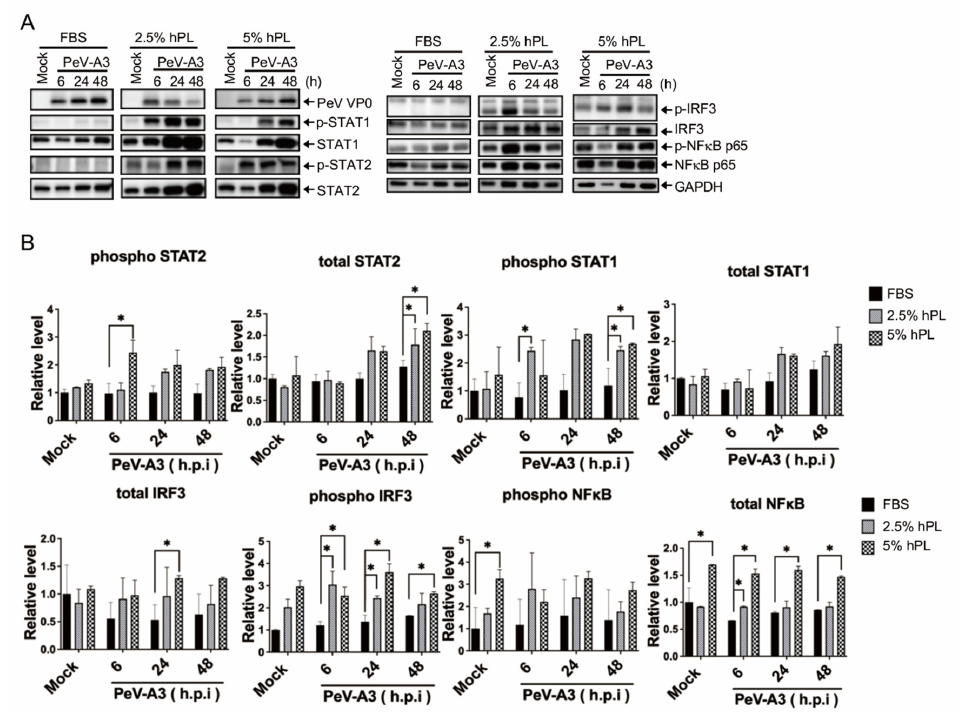
Figure 4. hPL-supplemented growth medium-induced expression of IFN-signaling pathway under PeV-A3 infection of GBM cells. ( A ) GBM cells were infected with PeV-A3 at MOI = 1 for 6 h, 24 h, and 48 h under FBS- or hPL-supplemented growth mediums. Cellular protein lysates were extracted to analyze IFN-signaling pathway by immunoblotting using anti-PeV VP0, anti-phospho- STAT1, anti-total STAT1, anti-phospho-STAT2, anti-total STAT2, anti-phospho-IRF3, anti-total IRF3, anti-phospho-NF κ B, anti-total NF κ B p65, and anti-GAPDH. ( B ) Quantification of different protein expressions was normalized to GAPDH. Data are mean ± SD of three independent samples. Student’s t -test, *, p < 0.05 compared with